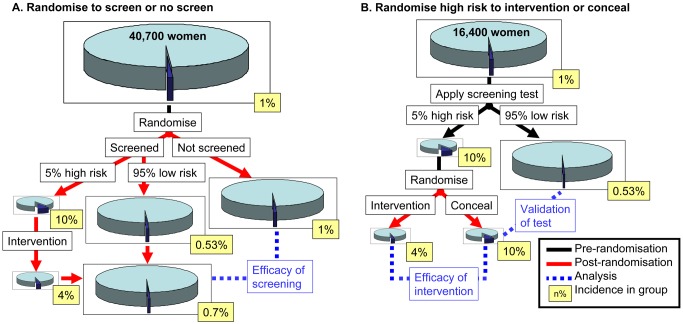
The effect of study design on sample size calculations and conclusions that can be drawn from screening studies.(A) Women are randomised to having or not having the screening test performed. (B) Women have the screening test performed and those who screen as high risk are randomised to having an intervention or having the result concealed. The number of women required (indicated in the top of each figure) is from a sample size calculation for 90% power to detect an effect at p<0.05 (two sided). In panel (A), it is the number of women who need to be consented to be randomised to being screened or not screened and the calculation is based on the rate of the primary outcome comparing screened versus not-screened. In panel (B), it is the number of women who need to be screened and it is based on the rate of the primary outcome comparing intervention versus no intervention among women who screened positive. Both calculations assume an outcome with a background incidence of 1%, a screen positive rate of 5%, and a positive predictive value of 10% (hence a positive likelihood ratio of 11). Based on these parameters, the 95% of the population who screened negative would have a 0.53% incidence, giving a negative predictive value of 99.5% and a negative likelihood ratio of 0.52. The intervention is assumed to reduce the risk of the outcome by 60%. See Table S1 for power calculations for both designs using other values of screening performance or intervention efficacy.